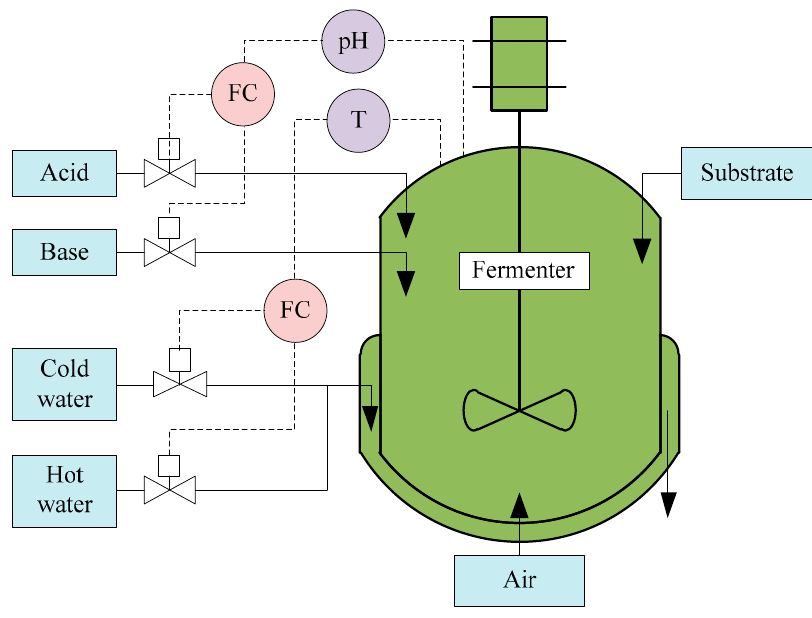
Figure 4. Flow diagram of penicillin fermentation process. Table 1. Input variables for soft sensor development in the penicillin fermentation process.